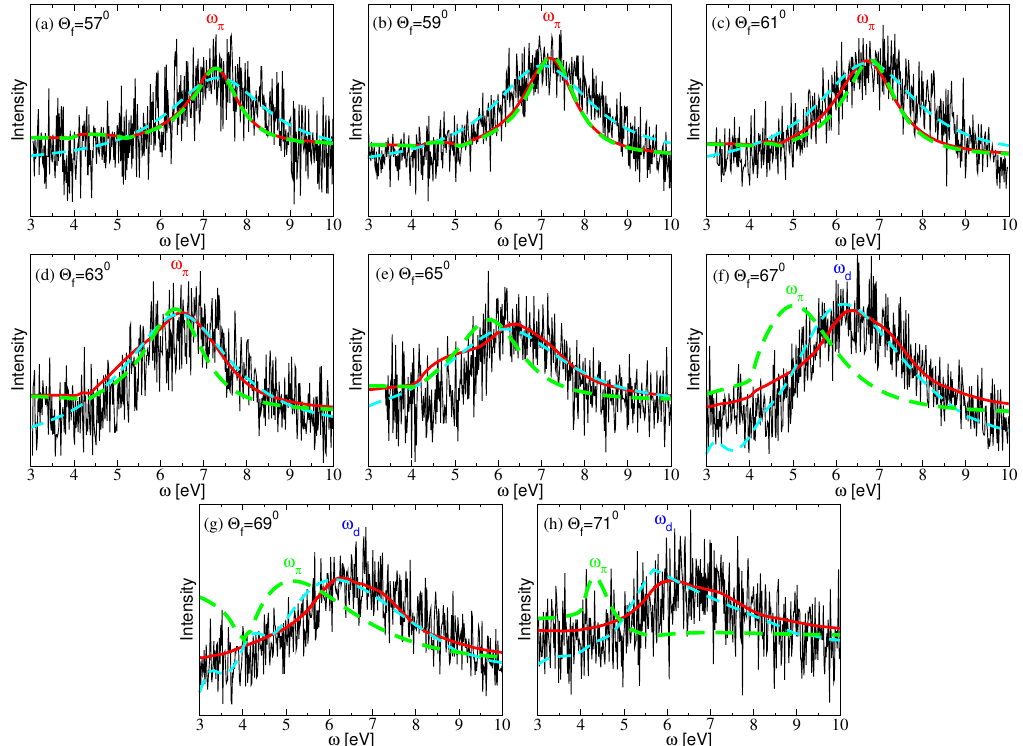
Figure 3. The experimental EELS spectra of the graphene/Pt-skin interface for various final (scattering) angles: ( a ) θ f = 57 ◦ –( h ) θ f = 71 ◦ (in steps of 2 ◦ ). The incidence angle is θ i = 65 ◦ and the incident electron energy is E i = 70 eV. The experimental data are compared with theoretical results for the energy loss function, −(cid:61) ( 1/ (cid:101) ) , obtained using two methods: ab initio calculations (red-solid) and an empirical model (magenta-dashed).The green dashed lines represent the EELS spectra of the self-standing graphene obtained using ab initio method, for